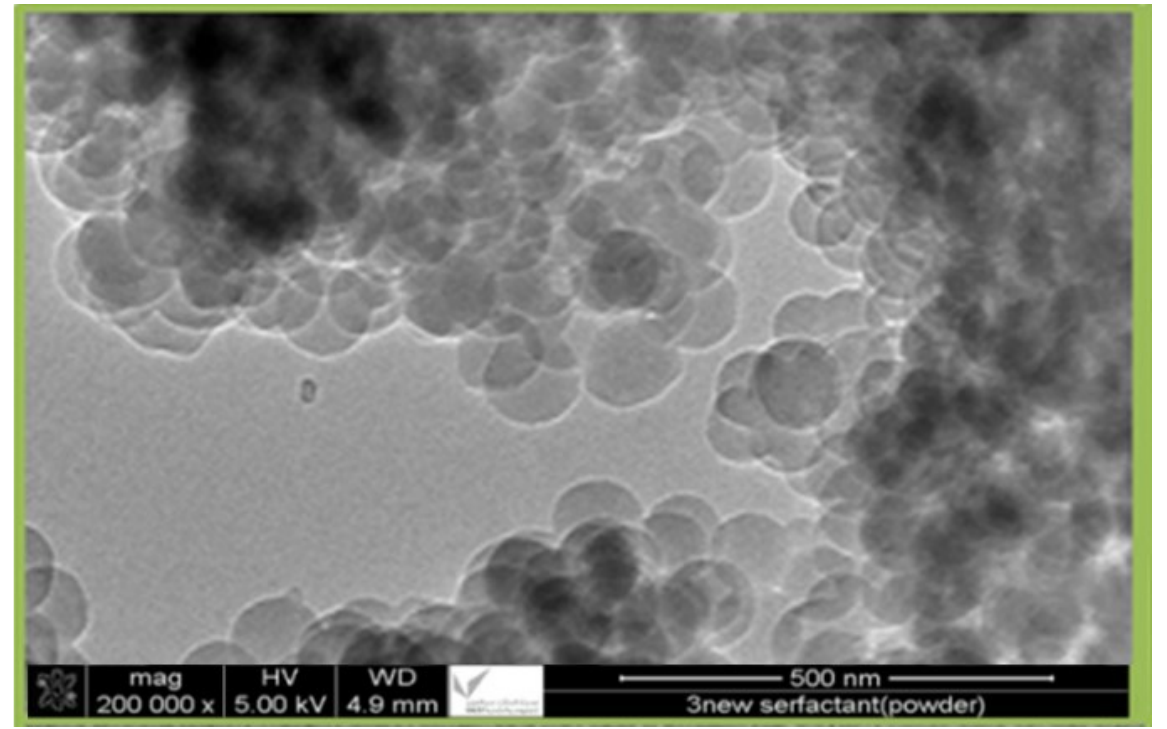
Figure 1. TEM of the nanocellulose (200,000×).